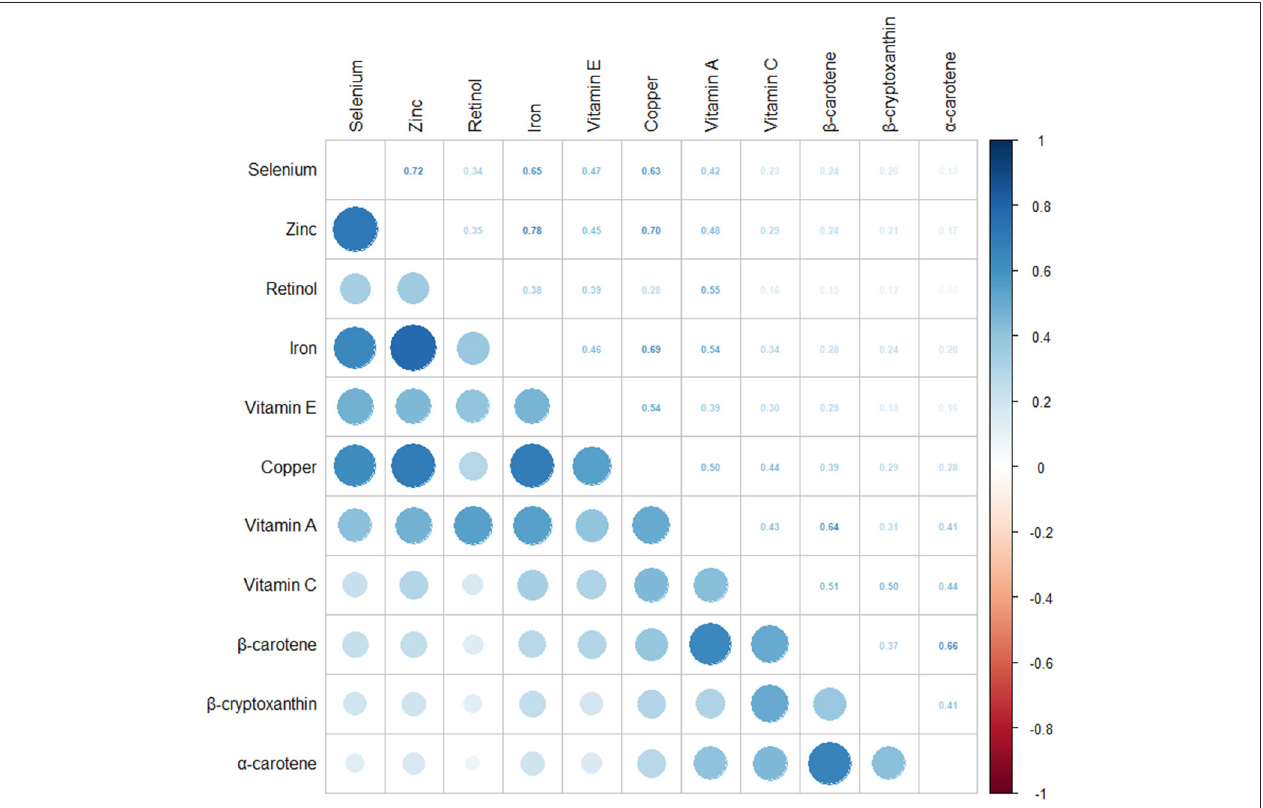
FIGURE 2 | Pairwise Pearson correlation coefficients between dietary intake of 11 antioxidant micronutrients in adults from the United States, collected from the National Health and Nutritional Examination Survey (NHANES) database 2003–2018.